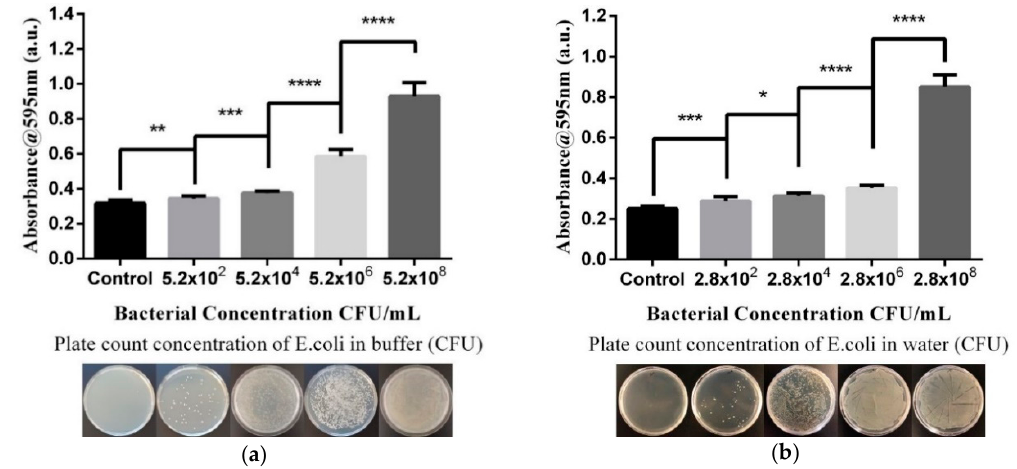
Figure 4. Absorbance value after reaction of bacterial amount and reagent ( n = 8), with the vertical axis indicating the mean intensity value of absorbance and the horizontal axis indicating concentration of bacteria in ( a ) PBS and ( b ) water. The data are measured using a Tecan sunrise ELISA reader. (* p < 0.05,